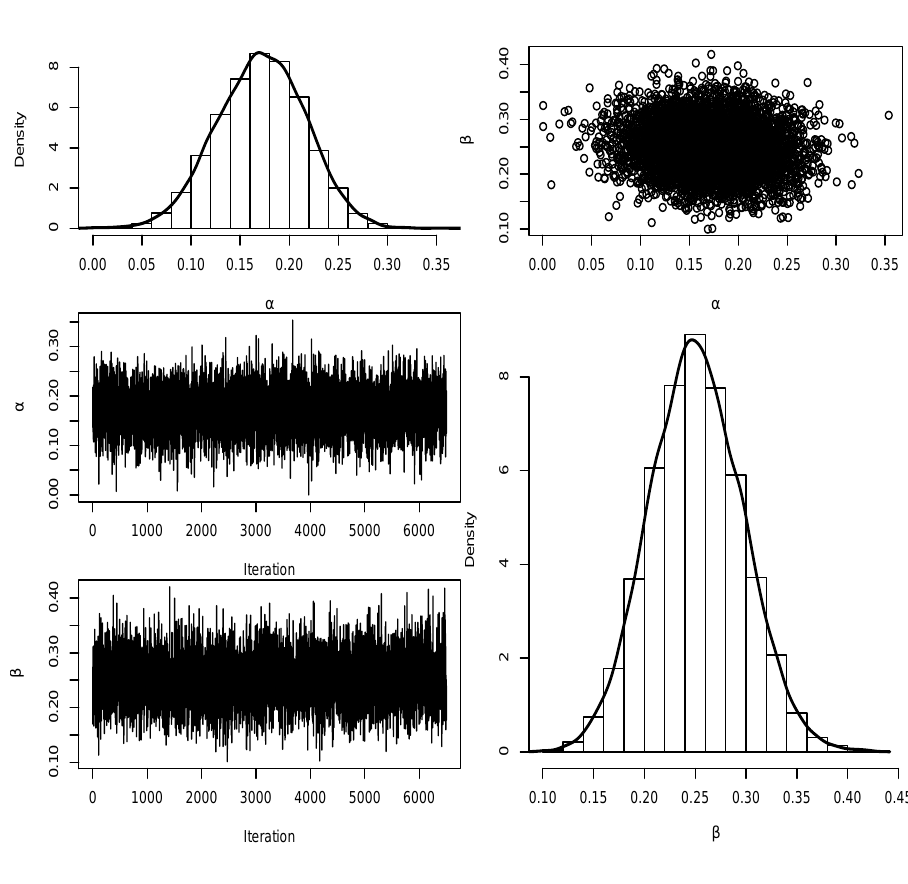
Figure 3 – Histograms, trace plots and scattered diagram of the posterior (Gamma-0) samples of α and β based on scheme 1.